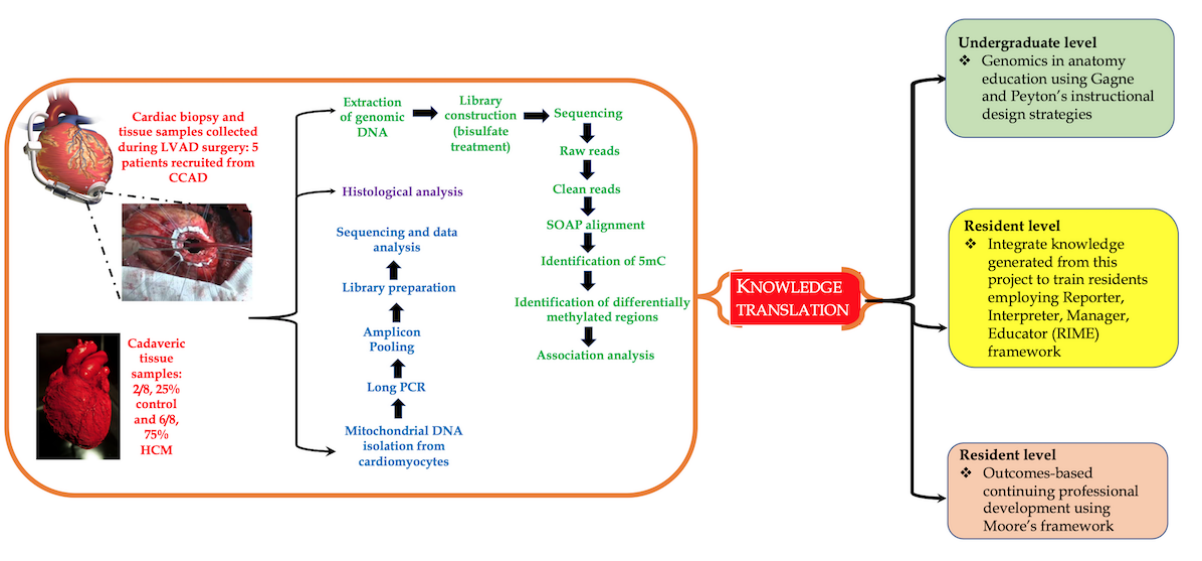
Figure 3. Summary of the proposed study; important steps are indicated (note: the results from this study will be used for competency-based medical education at different levels of training). 5mC: 5-methylation of cytosine; CCAD: Cleveland Clinic Abu Dhabi; HCM: hypertrophic cardiomyopathy; LVAD: left ventricular assist device; SOAP: short oligonucleotide alignment